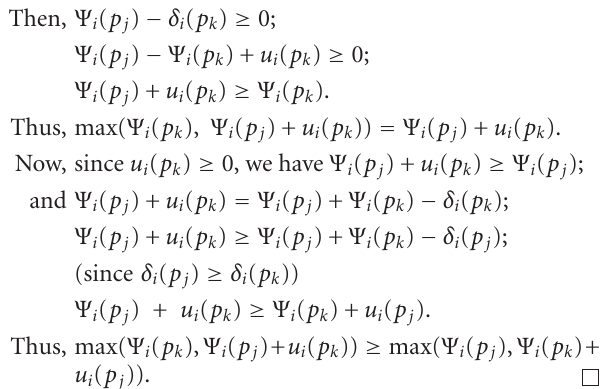
Figure 4: Resulting net with Type-I